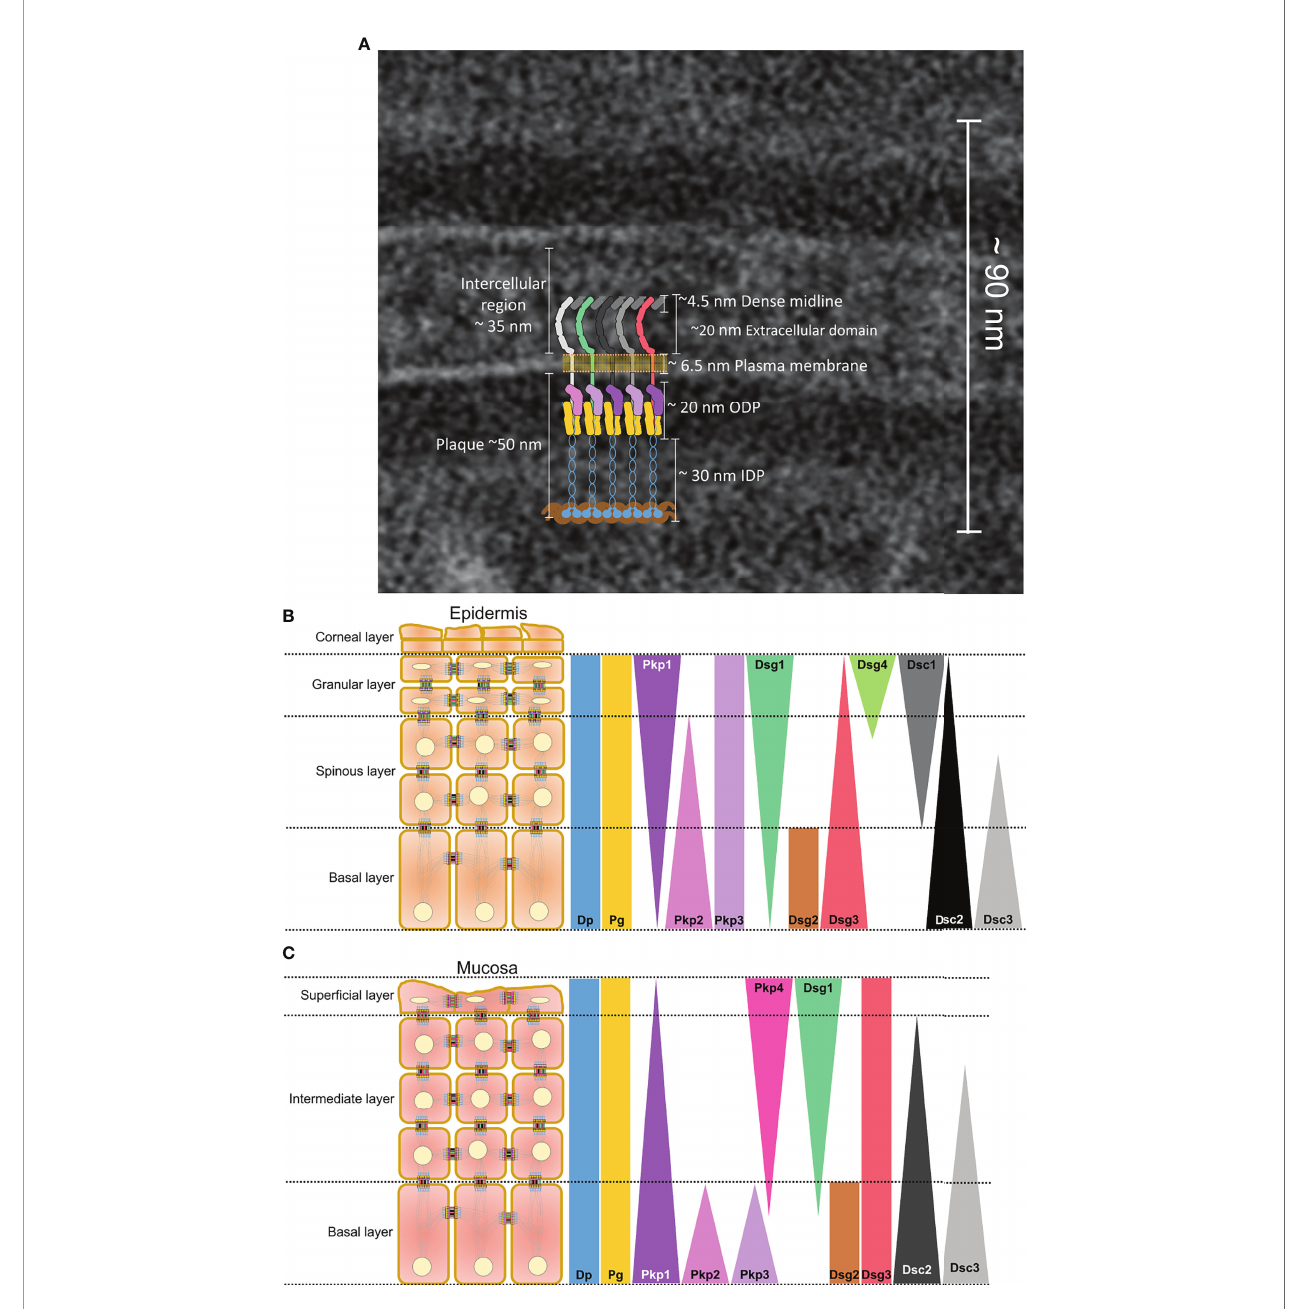
FIGURE 1 | (A) Electron micrograph showing single desmosome in a healthy skin with a superimposed schematic representation depicting molecular structure of a desmosome. Colour coding of each single molecule is the same as those represented in (B, C) . A schematic representation of the distribution of desmosomal proteins along the different layers of (B) epidermis and (C) mucosa. Small schematic desmosomes are colour-coded the same as the bars representing the